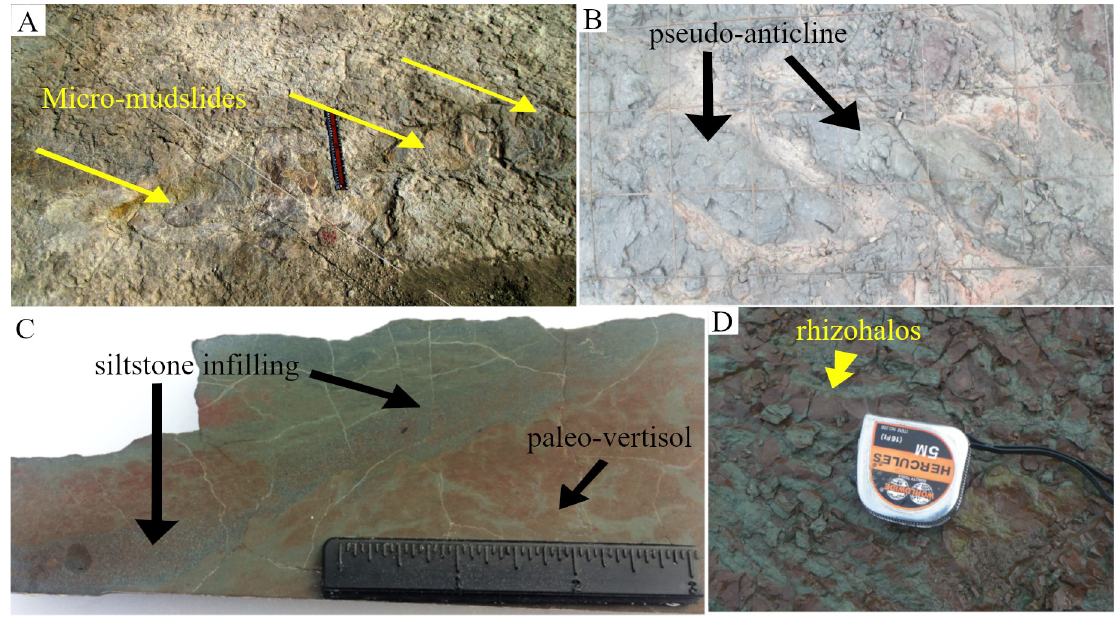
Fig 13. Some informative features of the paleo-vertisol along the C-D section. (A) Multiple-steps mudflow at the bank of the preserved abandoned channel. The preserved mudflow was located between Arch-5 and Arch-6. Note yellowish-brown oxidation coloration at the lower end of mud-flow. (B) Pseudoanticline: Note the visible micro-lows around the pseudo-anticlines. Black arrows point to the micro- highs. (C) A polished section from a cut-saw hand-sample from surface paleosol: Fine sand and silt size sediments filled a desiccation crack (fine sand and silt size sediment capped the forest floor and preserved it). (D) Light-olive green rhizohalos-like features in the weak-red paleosol matrix on the exposure of the capping paleosol close to the point-C: Note they have some of the features of the Eospermatopteris rhizohalos such as being equidimensional, non-branching and running in